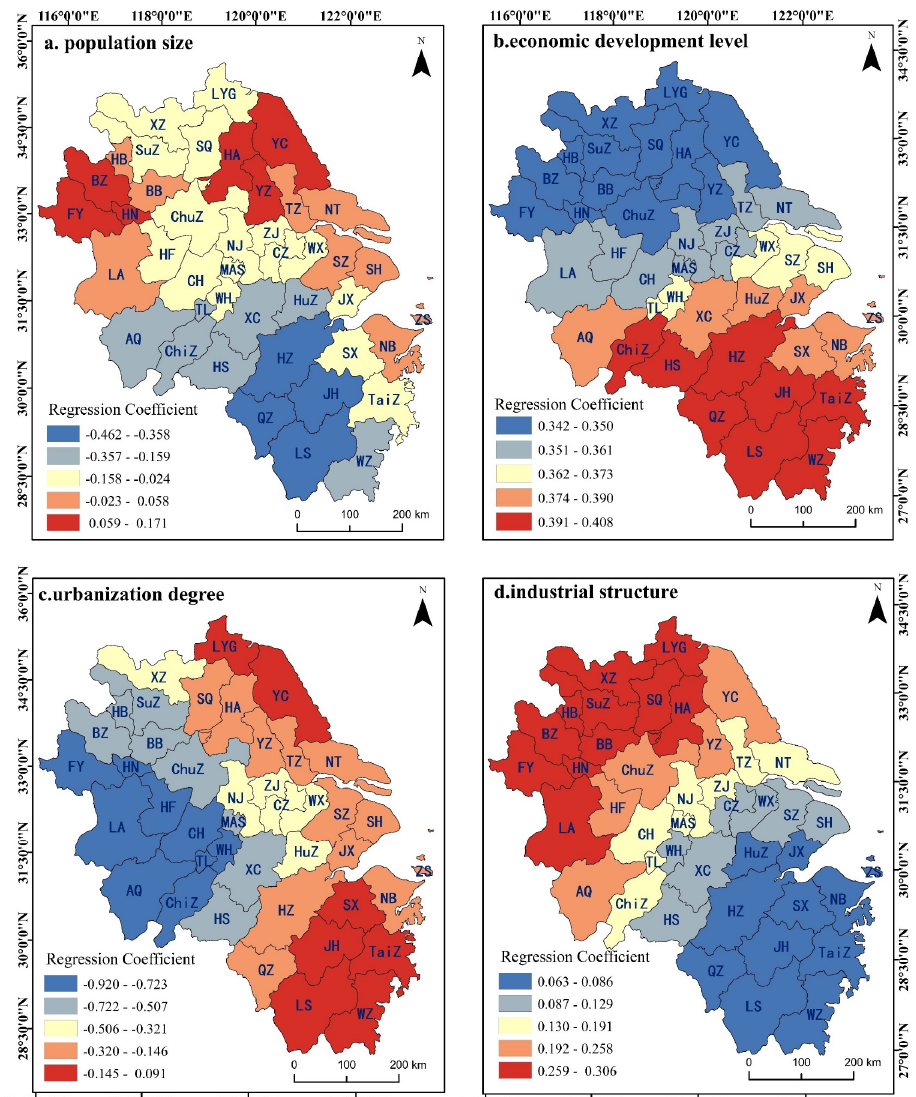
Figure 9. Spatial pattern of multi-scale geographic weighted regression coefficients from 1997 to 2017 in the Yangtze River Delta(( a ). Spatial pattern of regression coefficients of MGWR analysis of population size in the Yangtze River Delta from 1997 to 2017; ( b ). Spatial pattern of regression coef- ficients of MGWR analysis of economic development level in the Yangtze River Delta from 1997 to 2017; ( c ). Spatial pattern of regression coefficients of MGWR analysis of urbanization degree in the Yangtze River Delta from 1997 to 2017; ( d ). Spatial pattern of regression coefficients of MGWR anal- ysis of industrial structure in the Yangtze River Delta from 1997 to 2017).